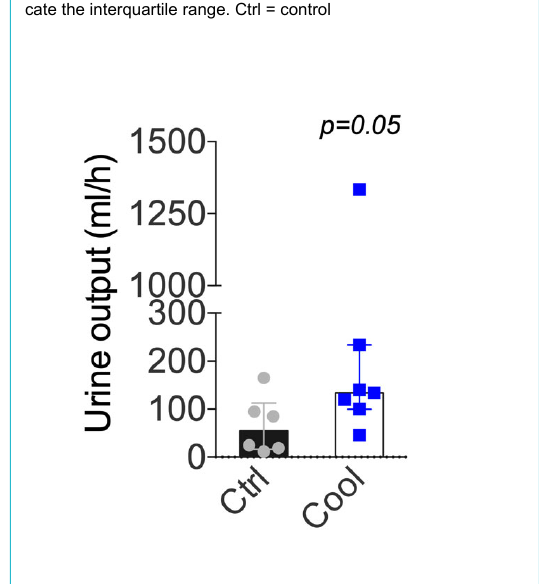
Figure 5: Urine output following transplantation. Mean urine output during the first hour after revascularisation. Errors bars indi- cate the interquartile range. Ctrl =